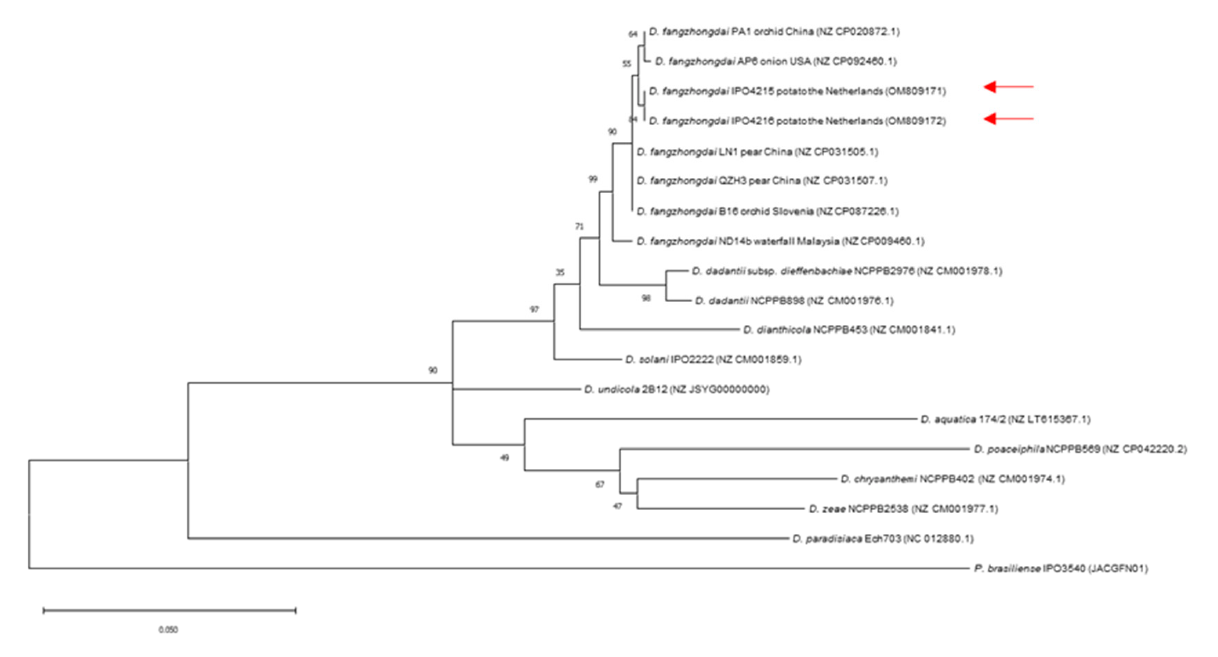
Figure 4. Maximum-likelihood phylogenetic tree of gapA sequences (762 bp) of Dickeya strains for identification of D. fangzhongdai (indicated with a red arrow), isolated from potato plants in the Netherlands. Bootstrap values greater than 40% are shown for 500 replicates. Concatenated sequences of Pectobacterium brasiliense were used as an out-group.